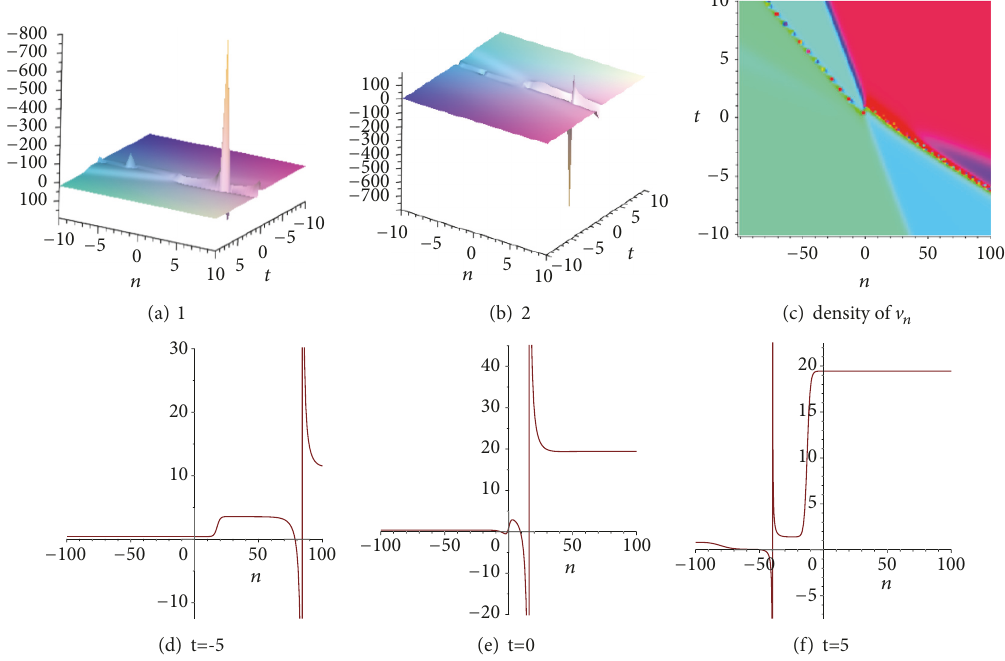
Figure 4: A structure of soliton solution for V 𝑛 in (68) with 𝜆 1 = 0.5,𝜆 2 = 2, 𝜆 3 = 1,𝜆 4 = 4, 𝛾 1 = 1, 𝛾 2 = −1, 𝛾 3 = 2, 𝛾 4 = −2 . Figures (a) and (b) are three-dimensional graphs of V 𝑛 , Figure (c) is the density plot of V 𝑛 , and Figures (d), (e), and (f) are structures of the solution V 𝑛 at different